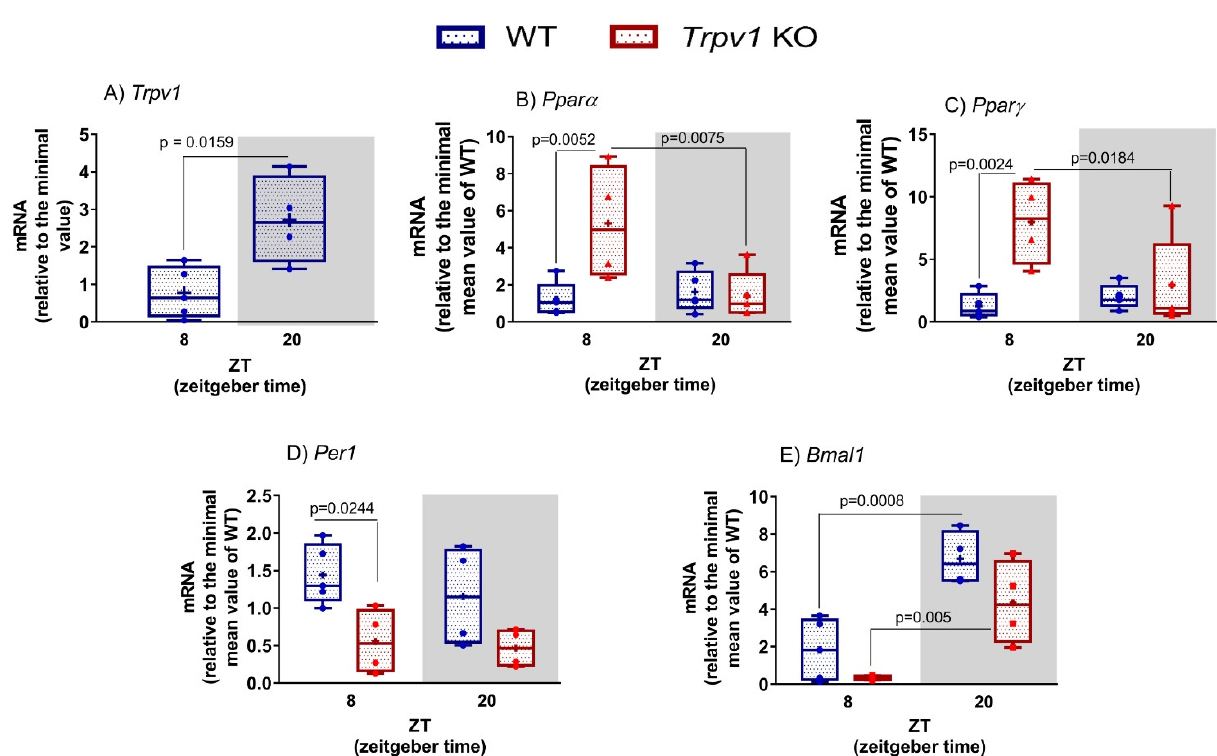
Figure 1. Gene expression in the liver of C57BL/6J WT and Trpv1 KO mice. ( A – E ) Gene expression in the liver at ZT8 (8 h after lights on) and ZT20 (8 h after lights off). Results are shown as median, quantiles, and maximum and minimum expression values of genes of interest normalized by 18S ribosomal RNA and expressed relative to the minimal value of WT mice. + represents the mean ( n = 4–5). In ( A ), statistical analysis was performed by Student’s t -test. ( B – E ) Significant differences between ZTs and between genotypes were demonstrated by two-Way ANOVA, followed by the Bonferroni post-test.